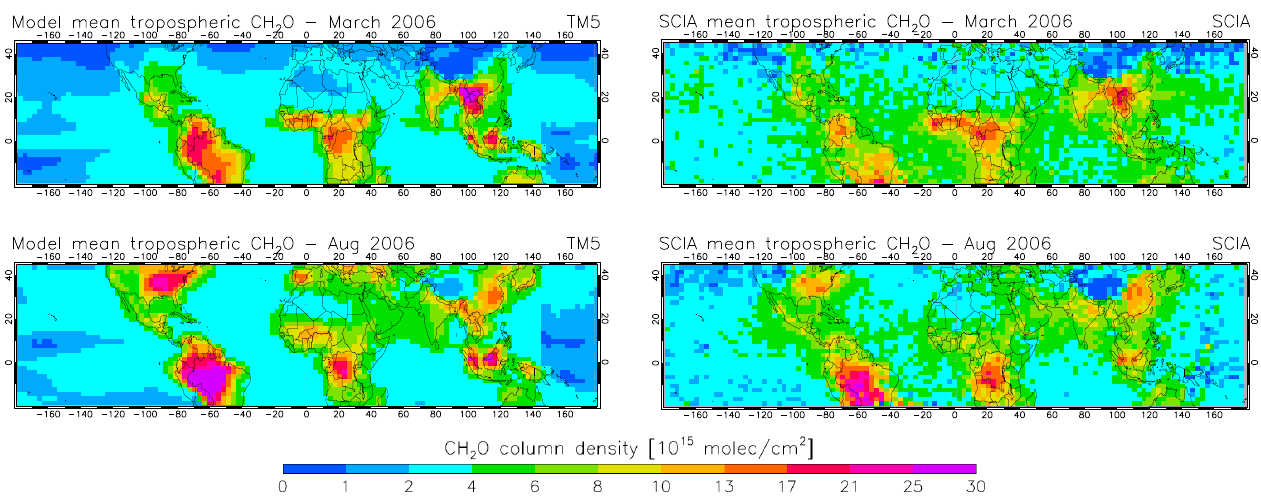
Fig. 7. TM5 true monthly average tropospheric CH 2 O column density in March and August 2006 vs. SCIAMACHY total columns retrieval.